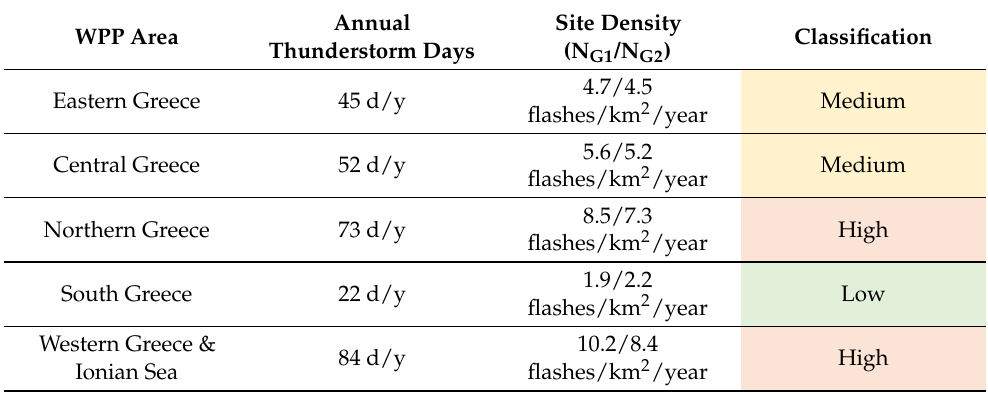
Table 3. Calculation of lightning density and classification.